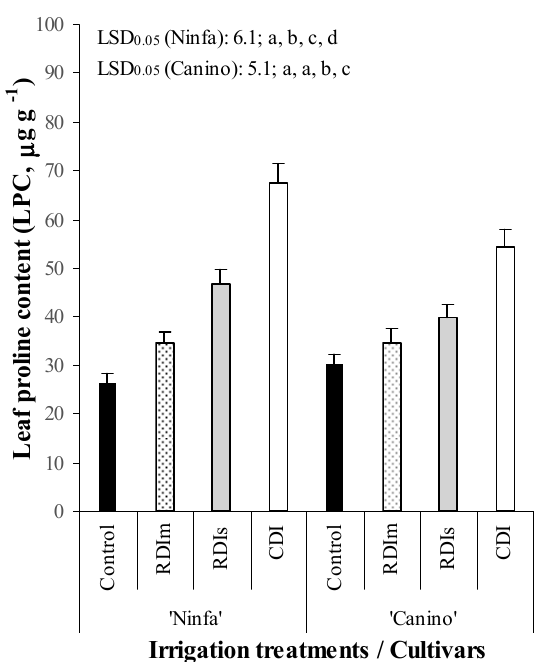
Figure 7. The effect of three years (2016, 2017, 2018) and two cultivars (‘Ninfa’ and ‘Canino’) on mean leaf proline content (TPC, µ g g − 1 ). Data are means of 2016, 2017 and 2018. Explanation for standard deviation values, irrigation treatments, calculations of significant differences, and explanations for LSD 0.05 values are given in Figure 3.